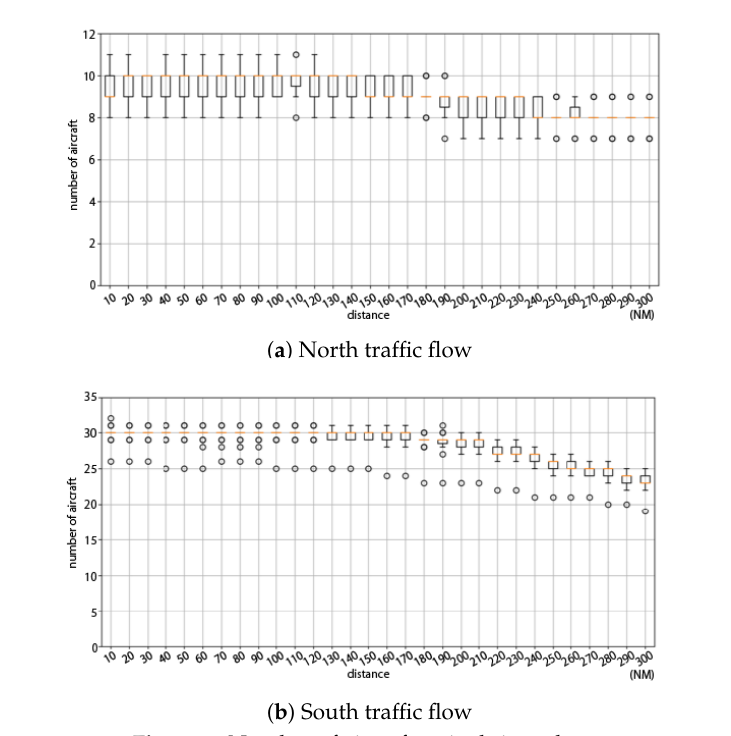
Figure 5. Number of aircraft arrivals in an